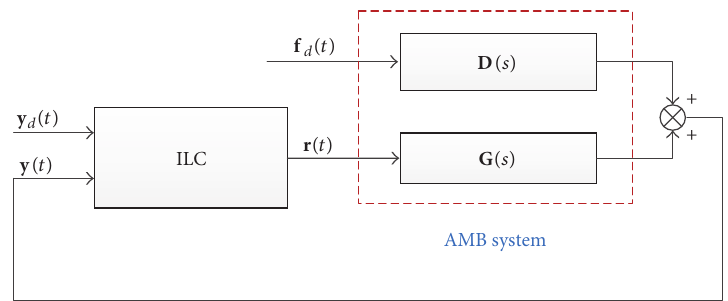
Figure 7: The AMB system with